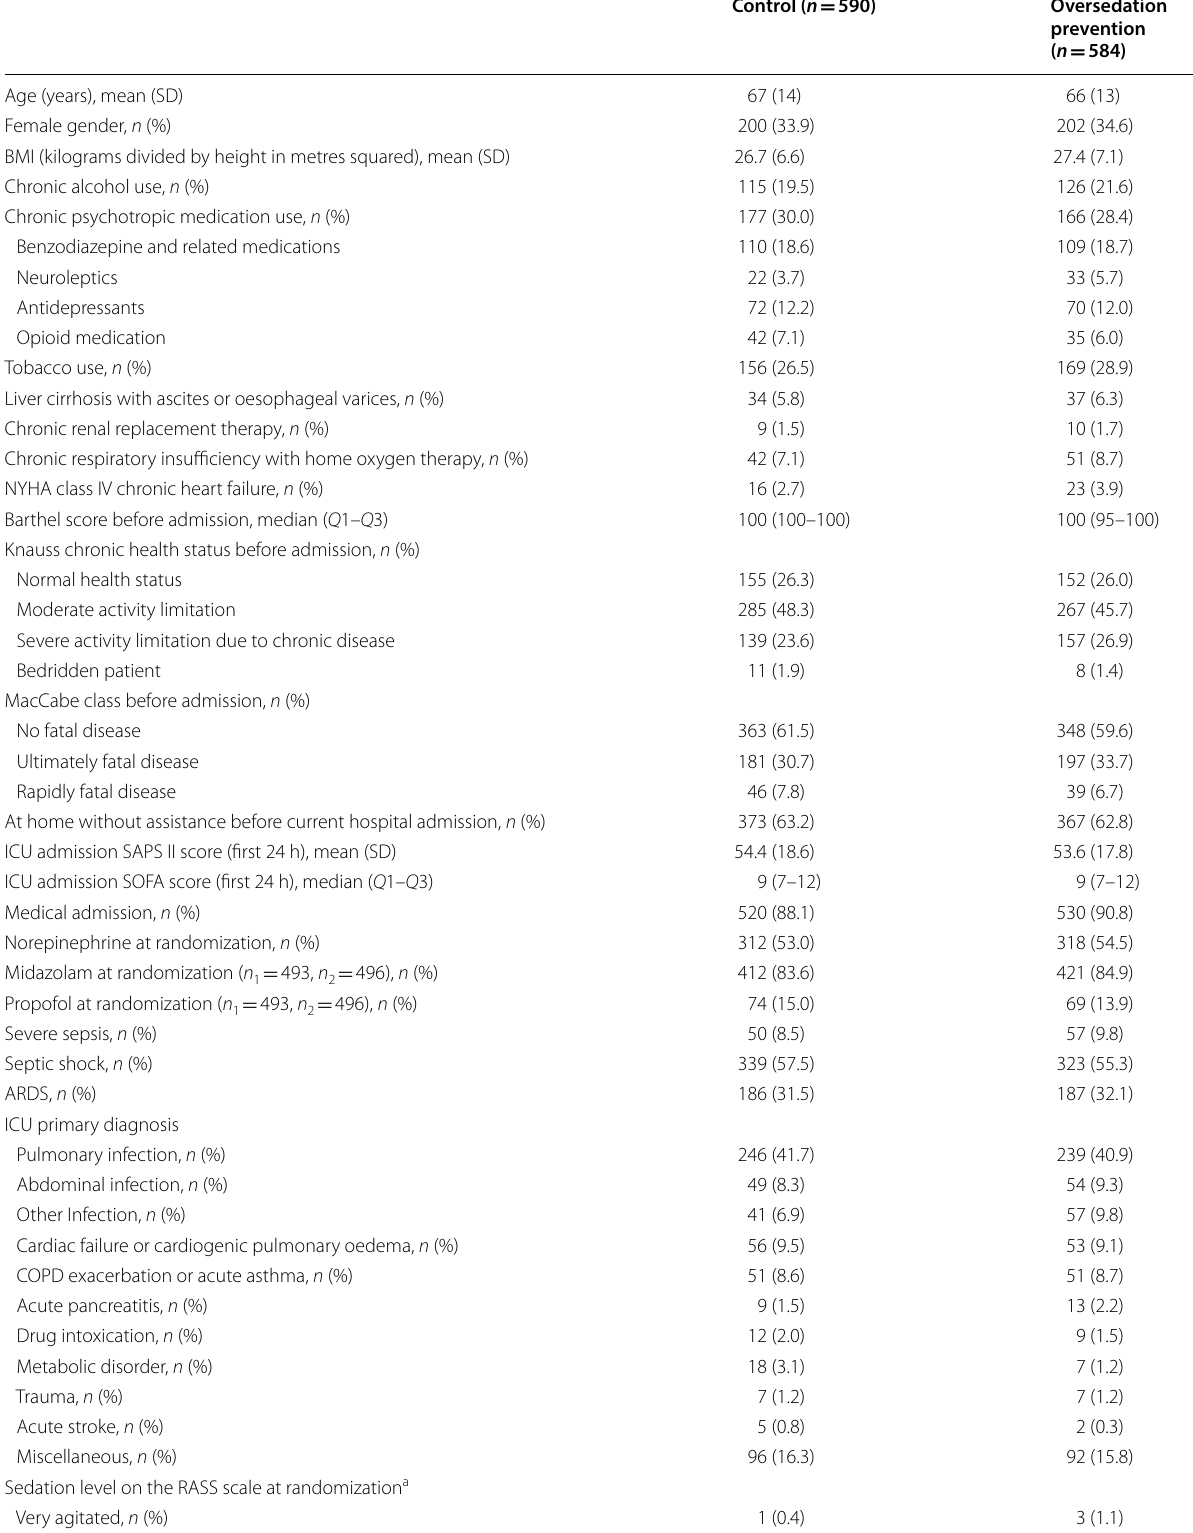
Table 1 Demographic and baseline characteristics at